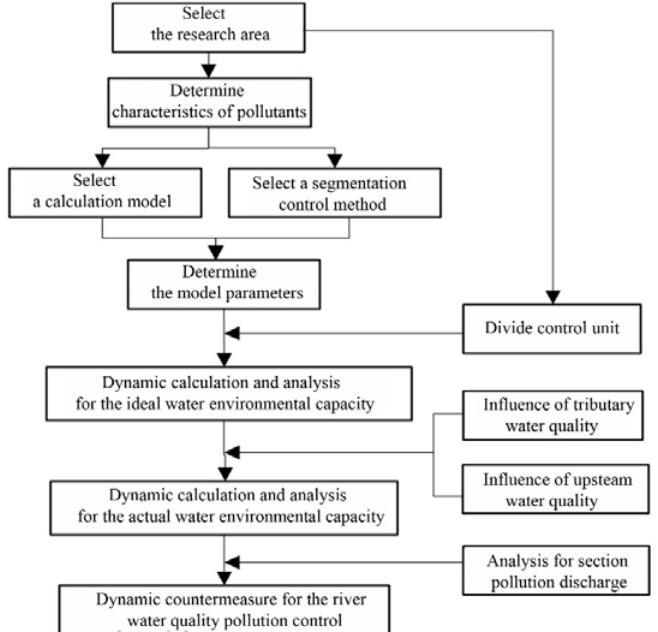
Fig. 3: Flowchart of load reduction planning at environmental function zones based on dynamic water environmental capacity